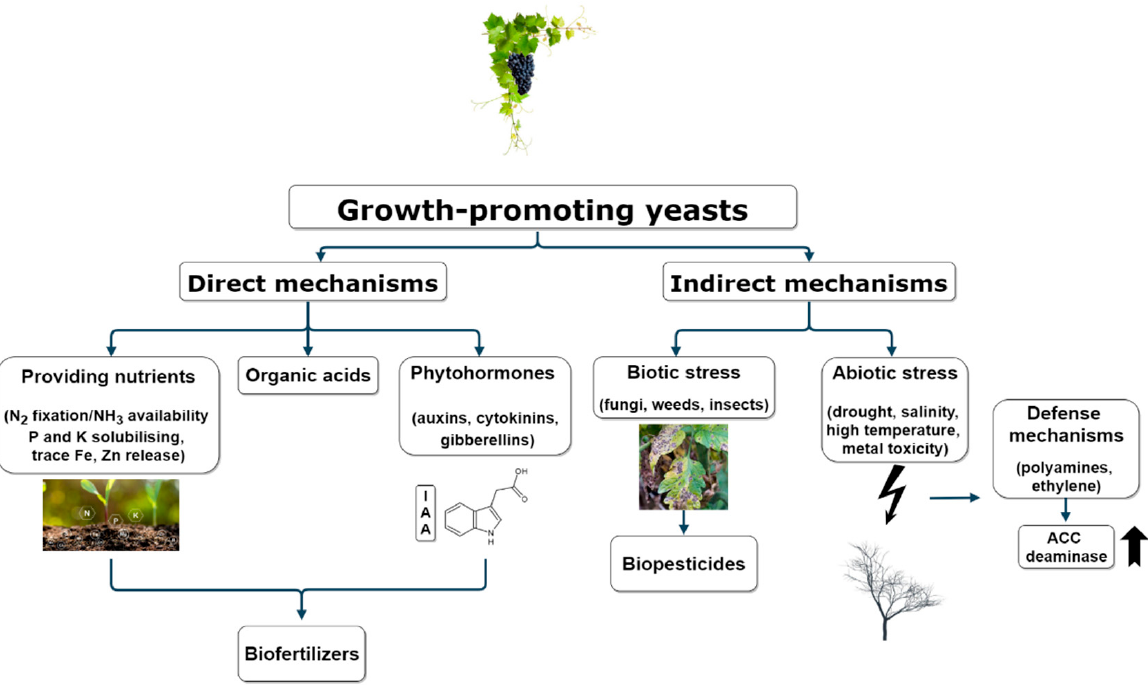
Figure 1. Modes of action of yeasts promoting plant growth.